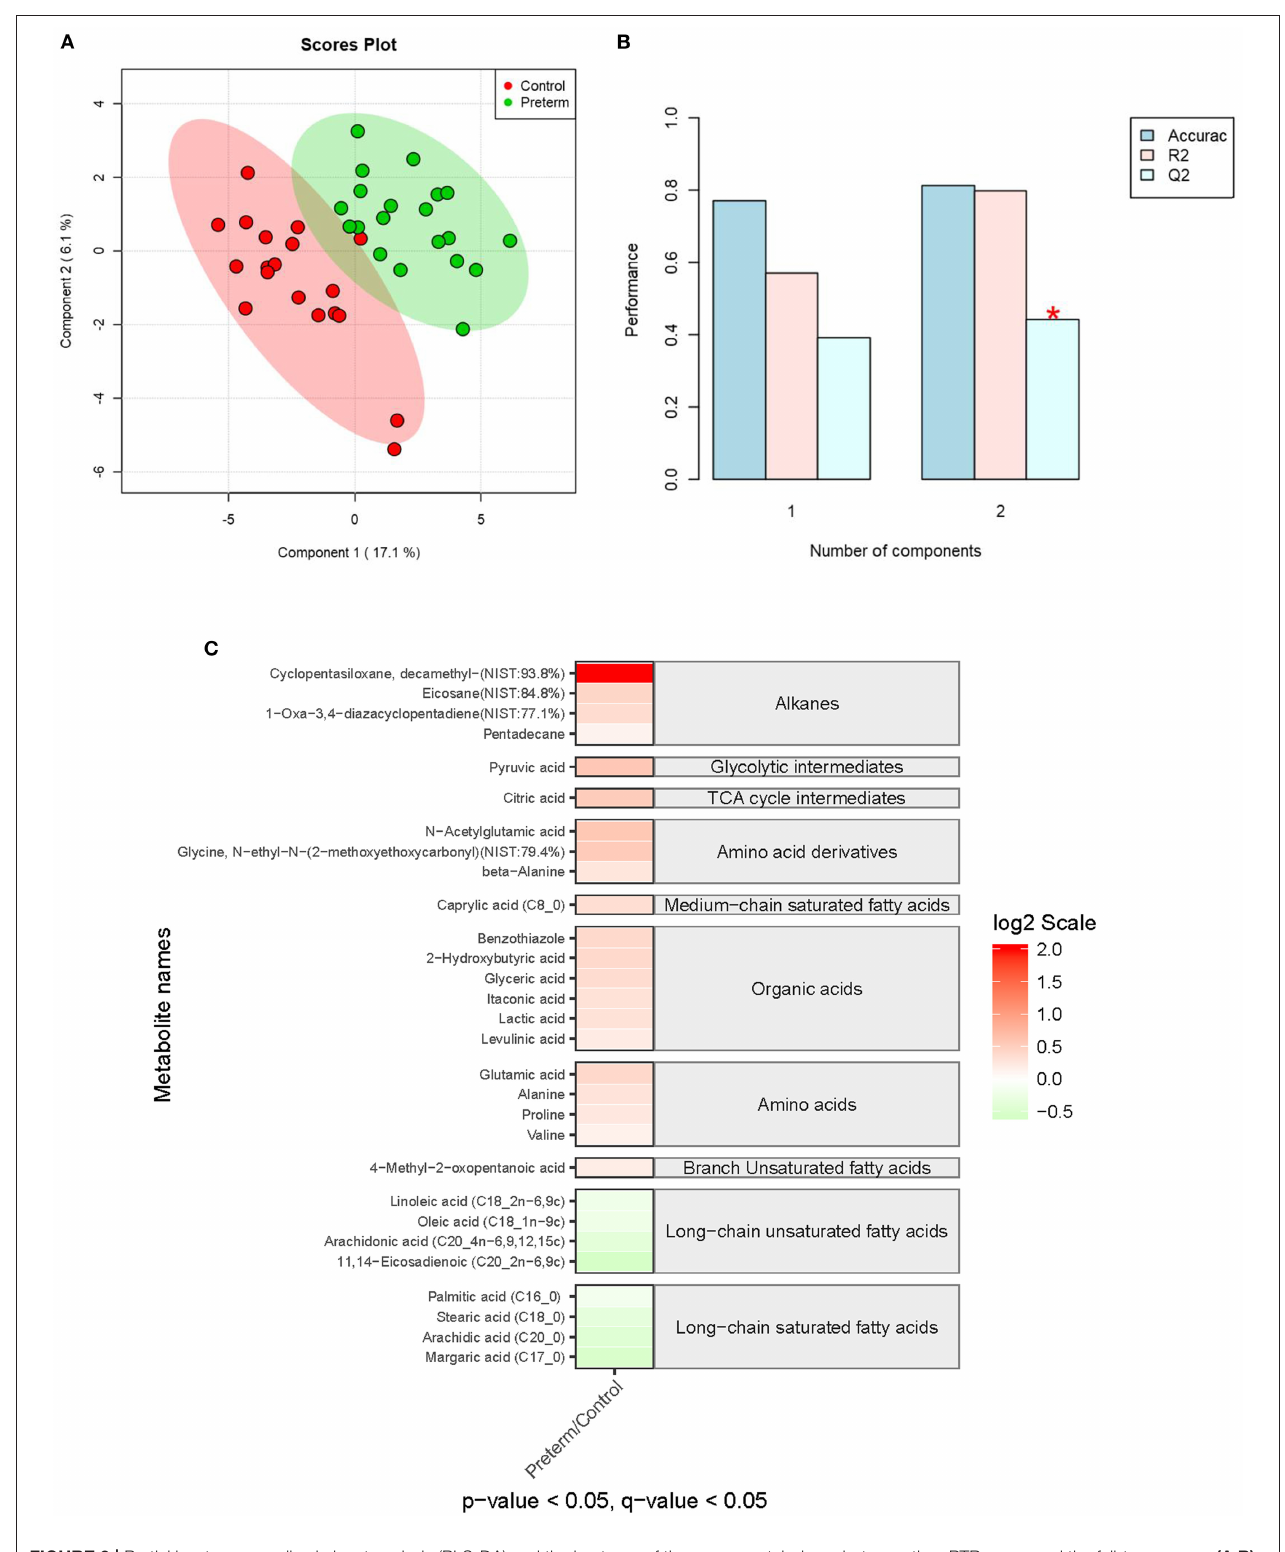
Frontiers in Pediatrics |